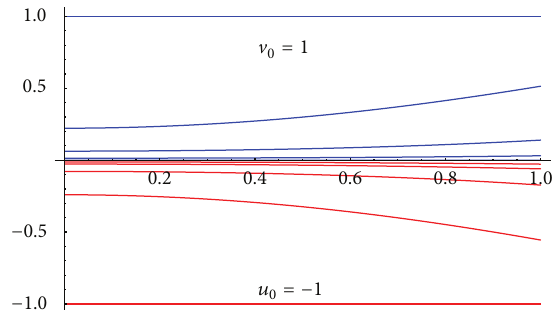
Figure 7: Plot of 𝑢 𝑛 (blue) and V 𝑛 (red), 𝑛 = 1,2, 3, 4,5 for 𝜆 = −1 .